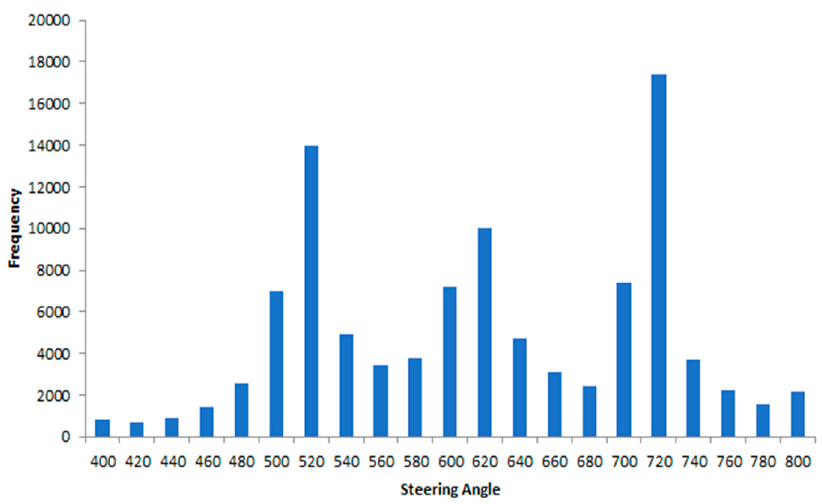
Figure 9. Histogram of the raw data acquisition.